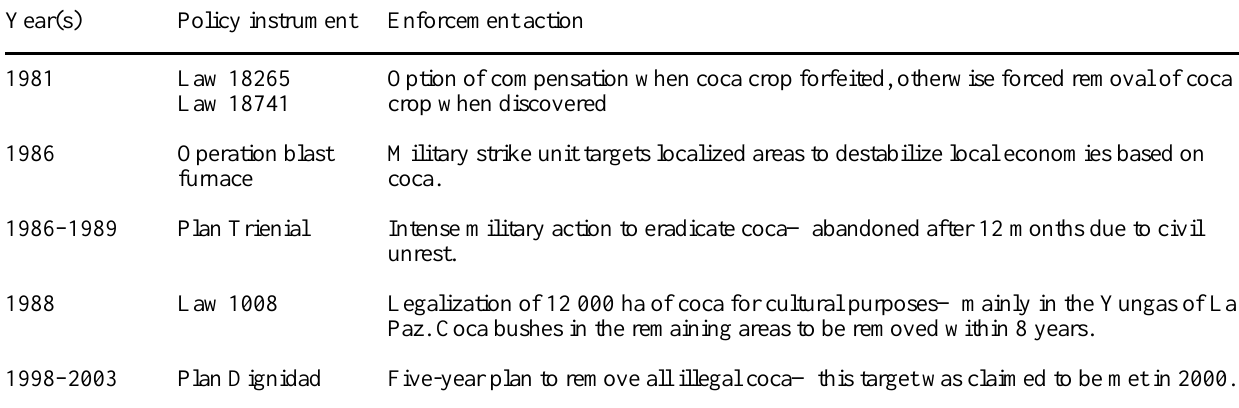
Table 1. Main periods during which military action was used to enforce anti-coca policies (sources: Cardozo et al. 1999, Ortuño 2002, Jackson et al.